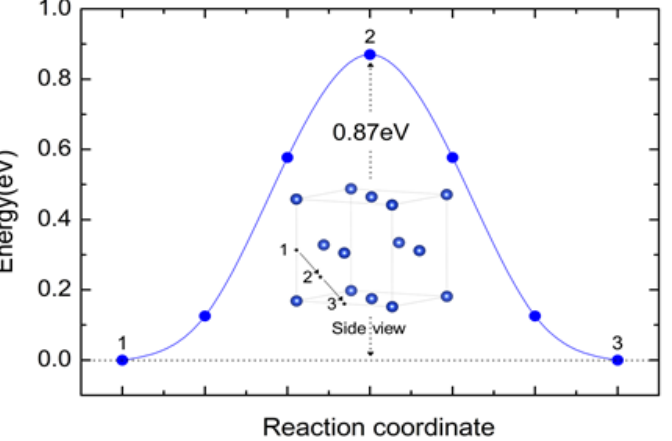
Figure 4. Diffusion energy profile and the diffusion paths between OISs for boron in copper. Site 1 and 3 denote the nearest OISs. Site 2 is the transitional state.